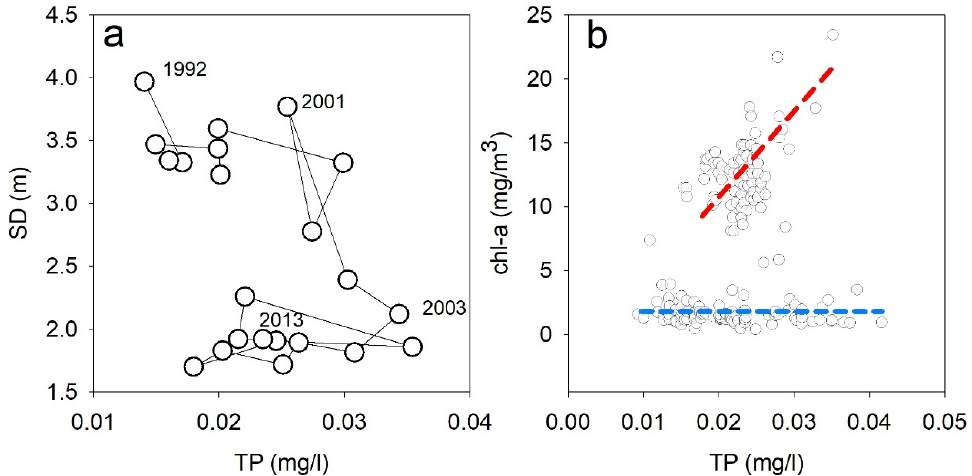
Figure 4. Phase plots of total phosphorus (TP) against water clarity (SD) and chlorophyll-a (chl-a) as a proxy for phytoplankton concentrations during the period 1992 to 2013. ( a ) The TP vs. SD plot of mean annual data from one sampling site tracks a fold bifurcation between the lake’s main driver (TP) and lake’s state (SD), with a transition between two stable states during the period 2001–2003. For TP values 0.018–0.040 mg/L, the lake can exist in either clear or turbid alternate states. ( b ) The TP vs. chl-a plot of mean annual data from 12 regular monitoring sites [26] shows a linear, positive relationship for a high algal state (red dashed line) and no relationship for a low algal state (blue dashed line).